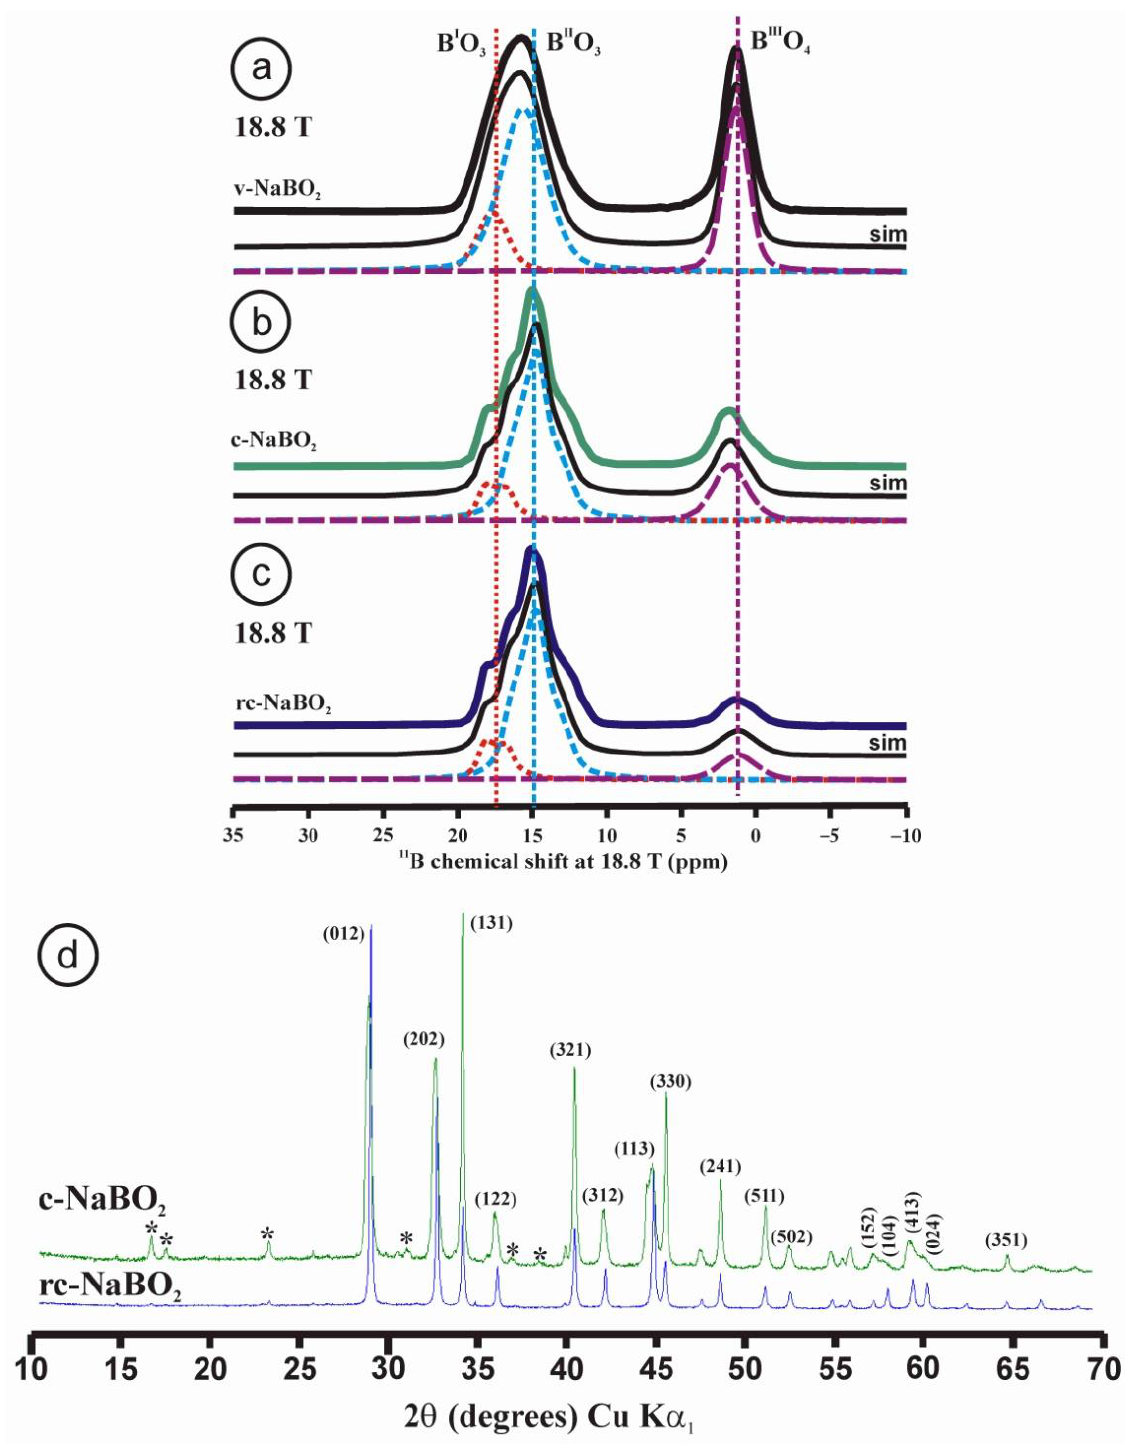
Figure 4. 11 B MAS NMR spectra at 18.8 T of v-NaBO 2 glass sample ( a ), crystallized c-NaBO 2 ( b ), and recrystallized rc-NaBO 2 ( c ). In ( d ) powder XRD patterns of samples c-NaBO 2 (green) and rc-NaBO 2 (violet), with some (hkl) diffraction maxima from NaBO 2 in file CC = 34,645 (file pdf 32-14046), and an impurity (with *) of NaBO 2 · 2H 2 O. In ( a ) three Voigt curves, related to three boron atoms (B I , B II and B III ), are used to simulate the spectrum. In ( b , c ) quadrupolar profiles were inferred from the experimental spectra for B I and B II , whereas Voigt curves were used to simulate B III . The 11 B MAS NMR spectra were obtained as a result of pulses of π/2 at 150 μs and 4.96 W, υ r = 16 kHz, at 18.8 T, in a 2.5 mm rotor. See the numerical values of the deconvolutions in Table 3. Table 3. Deconvolution of the 11 B spectra at 18.8 T in the three samples of NaBO 2 in Figure 4. Sites